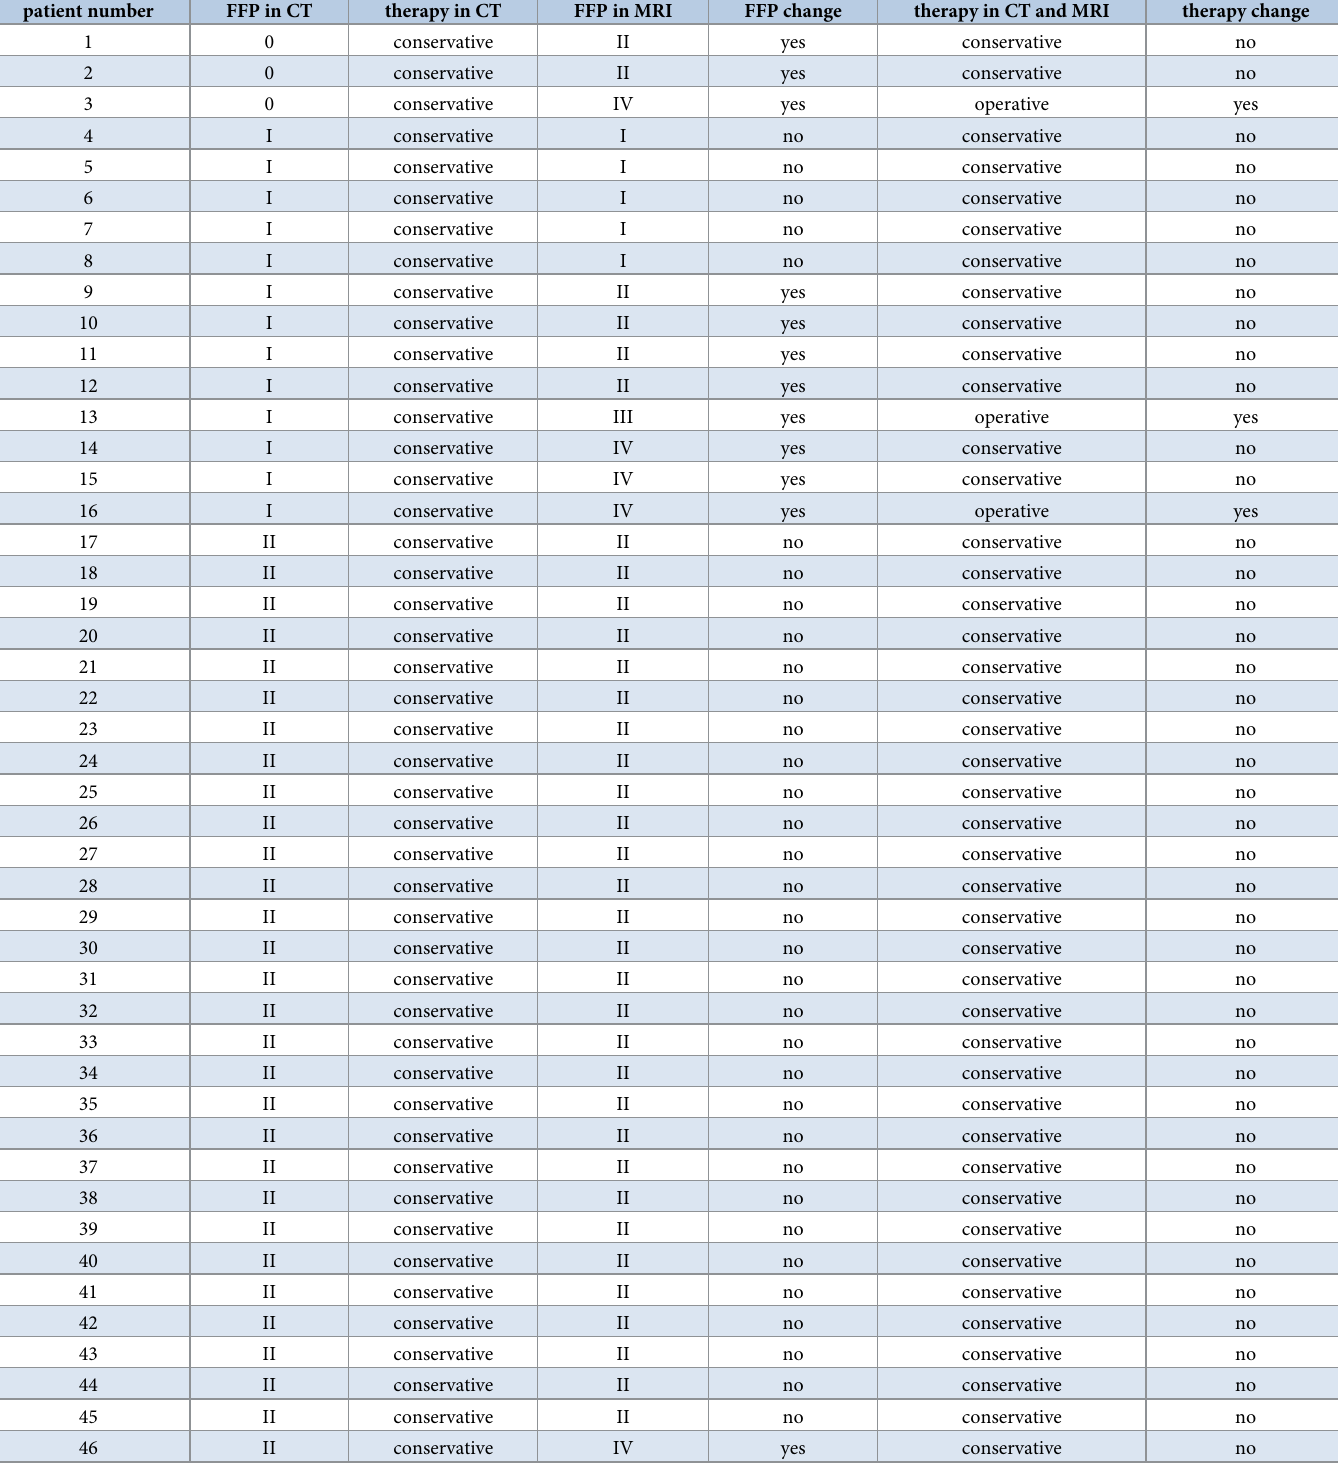
Table 3. Distribution of all patients according to the fragility fracture of the pelvis classification according to Rommens comparing CT and MRI: No fracture in CT in 3 patients, FFP I (13 vs. 5 patients), FFP II (34 vs. 35 patients), FFP III (6 vs. 2 patients) and FFP IV (11 vs. 25 patients). patient